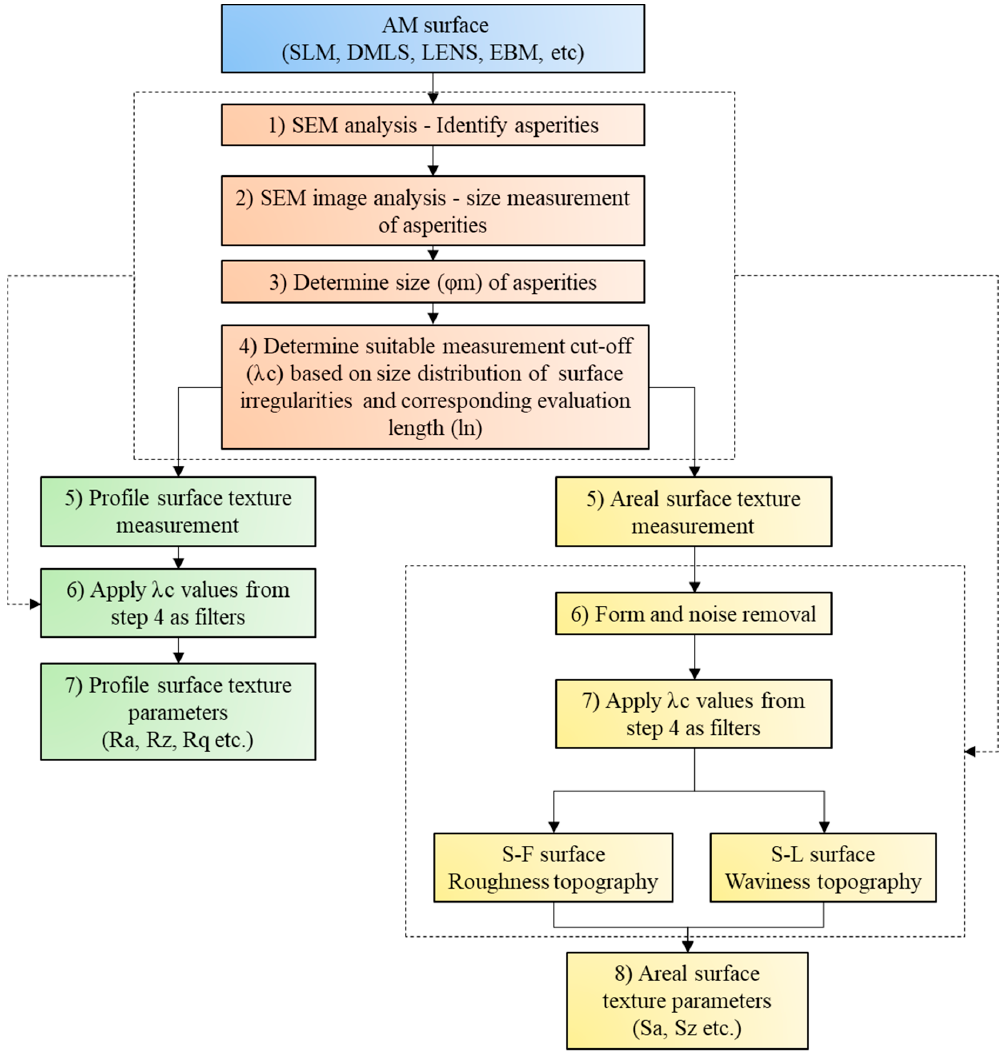
Figure 1. Investigative measurement framework. Figure 2. shows the effect of applied λ c and the resulting output topographies. Ini- tially, the AM surface is measured, and a profile/topography is obtained. The resulting surface is known as an S-F surface. The S-F surface contains errors largely due to loosely attached particles, partially melted particles, balling melts, semi-welded structures, stair- case effect, etc.